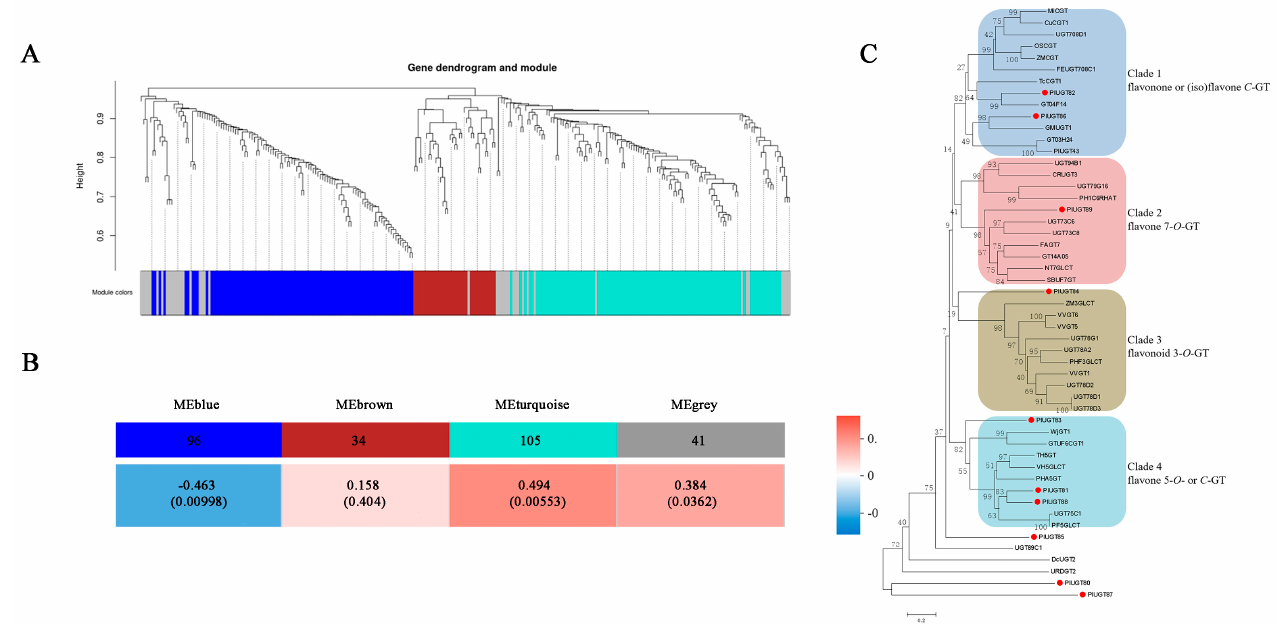
Figure 4. Analysis of the P. lobata glycosyltransferase (PlUGT) genes. ( A ) Clustering diagram of the 267 PlUGTs by their gene expression patterns. ( B ) Weighted gene coexpression network analysis (WGCNA) for the correlation of the expression modules consisting of 276 P. lobata UGT genes and the puerarin-accumulation trait. ( C ) Phylogenetic analysis of the 10 top-ranked PlUGT candidates selected from this study with the previously published known C - and O -glucosyltransferases. The tree was constructed using the neighbor-joining method using MEGA 6.0 software with 1000 bootstrap replicates. Accession numbers of the previously characterized C - and O -UGTs are shown in Table S5 (Supplementary Materials).